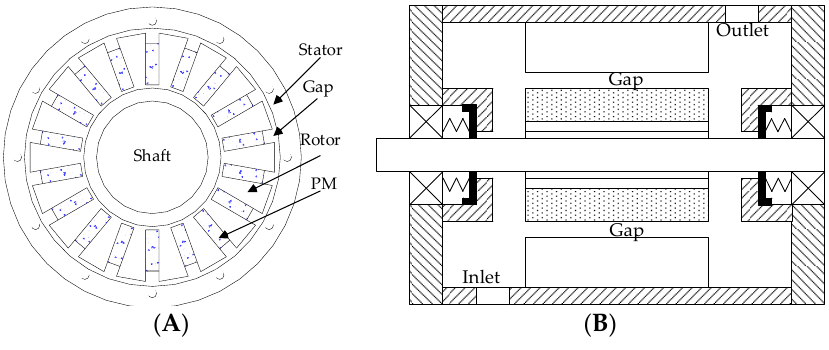
Figure 1. Structure of the converter: ( A ) axial direction and ( B ) radial direction.